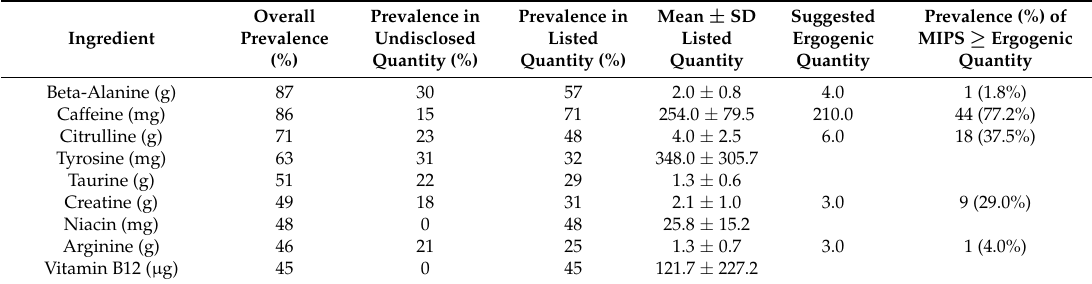
Table 1. Prevalence and quantities of ingredients included in the bestselling pre-workout supplements ( n = 100). MIPS: Multi-ingredient pre-workout